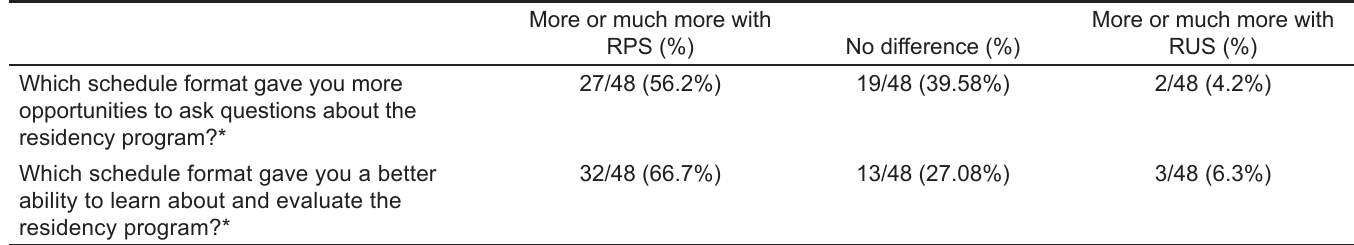
Table 3. Familiarity with residency